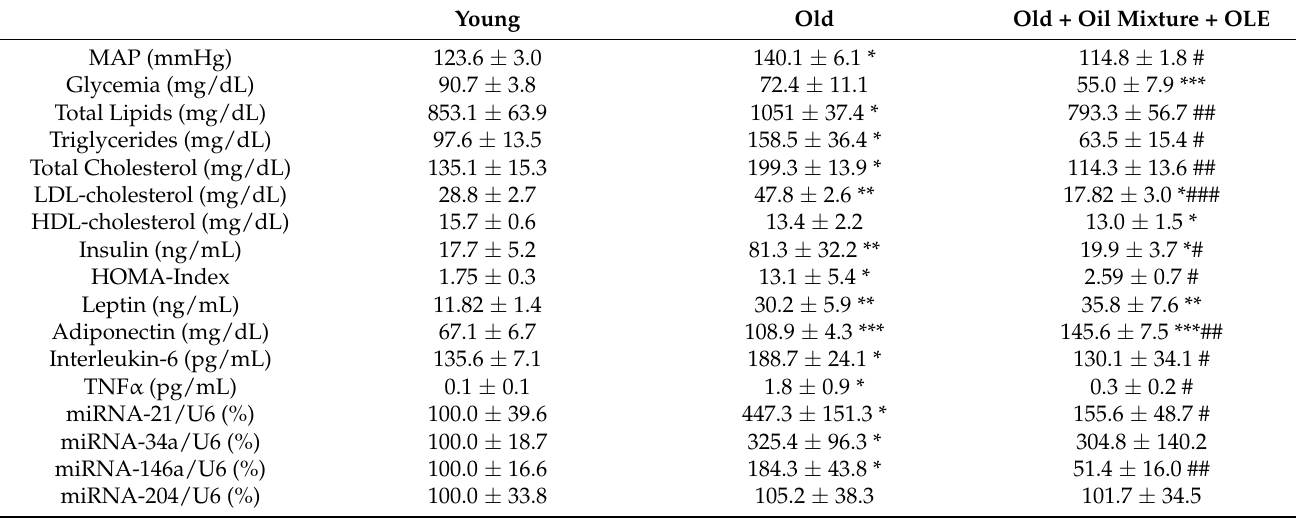
Table 3. MAP, lipid profile, hormone concentrations, inflammatory parameters and miRNA levels in the serum of young rats, old rats and old rats treated with the oil mixture and the